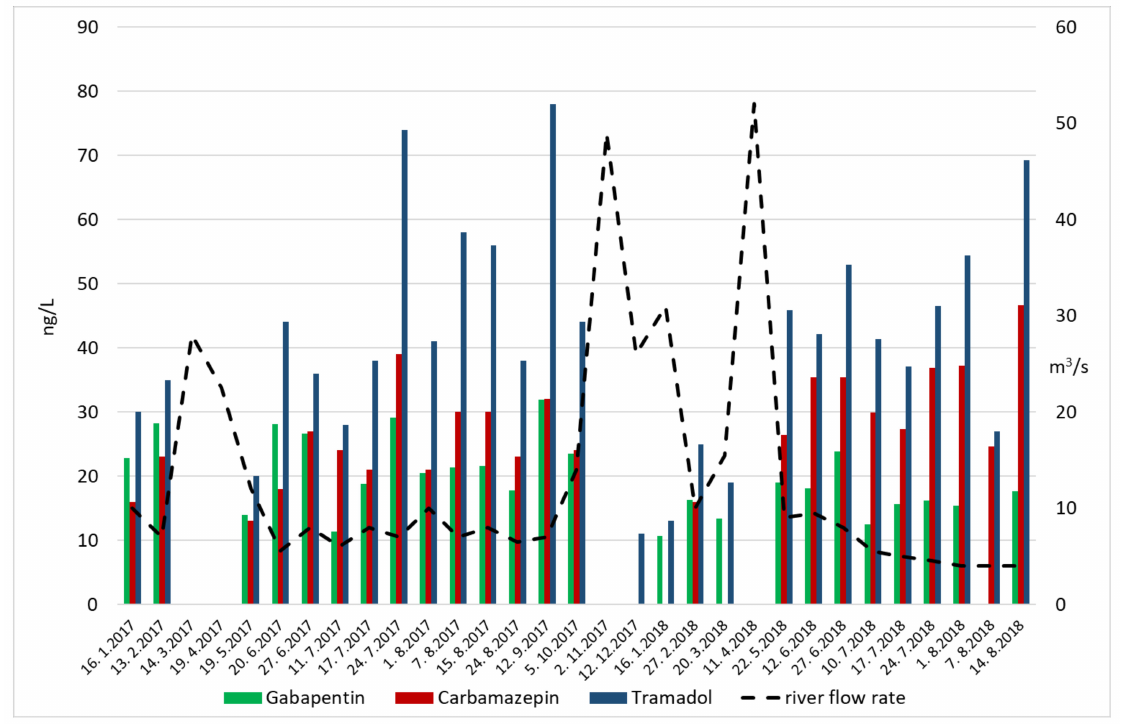
Figure 8. Changes in concentrations of selected PPCPs on profile No. 5 in relation to water